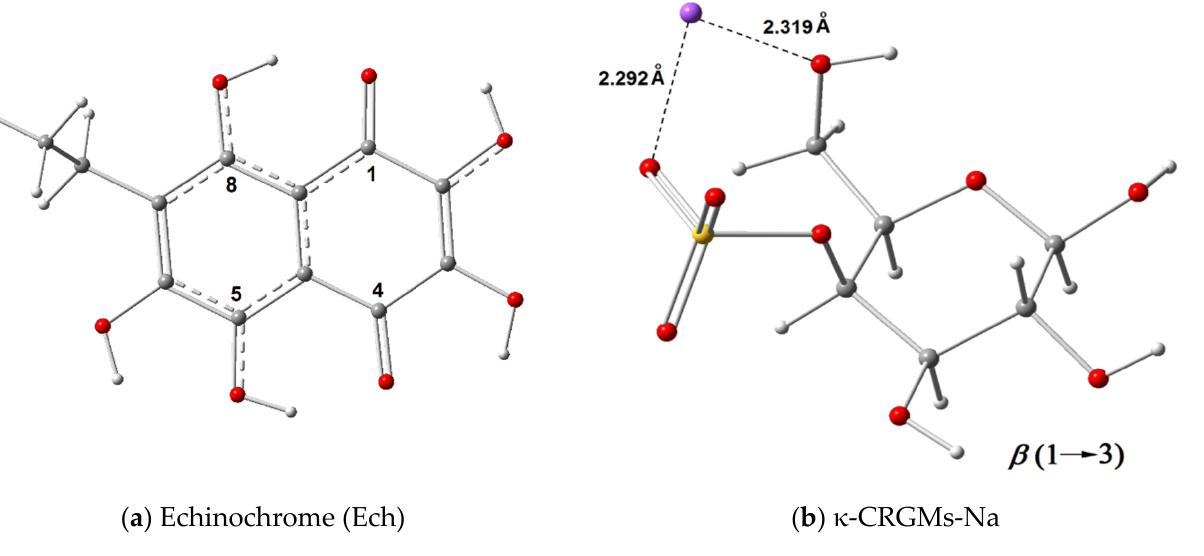
Figure 3. ( a ) Structure of Ech; ( b ) structure of monosaccharide—4-sulfat-Na-1,3- β -D-galactose of